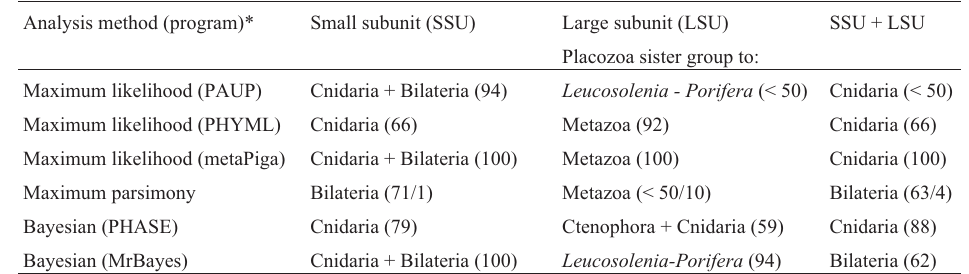
Table2 -Placozoasistergroupineachanalysis.Supportvaluesareshowninparentheses:posteriorprobabilityvaluesforBI,bootstrappercentvaluesfor mL, and bootstrap percent values and Bremer support for